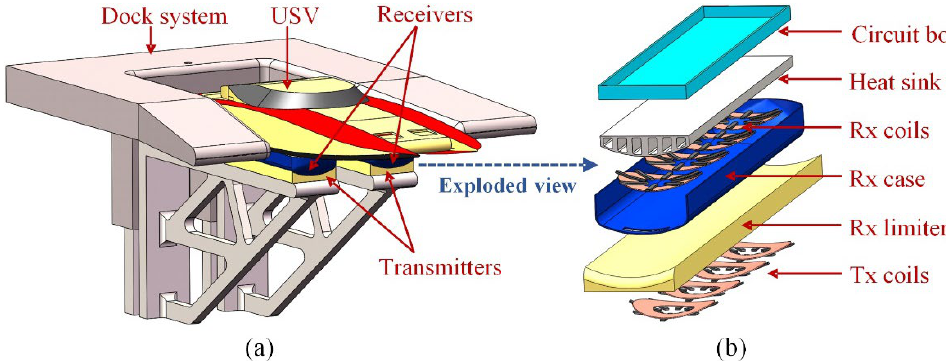
Figure 1. Overview of UWCS. ( a ) Assembly of a transmitter in dock system and receiver in USV. ( b ) Exploded view of transmitter and receiver.